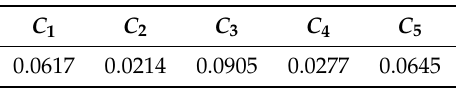
Table 9. The Euclidean distance d j .